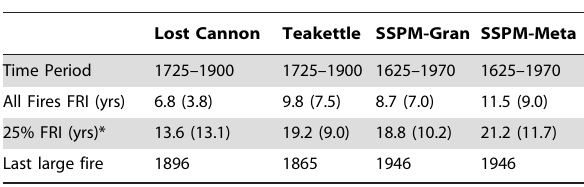
Figure 2. Proportion of trees within separate size classes in four old-growth Jeffrey pine-mixed conifer forest sites.